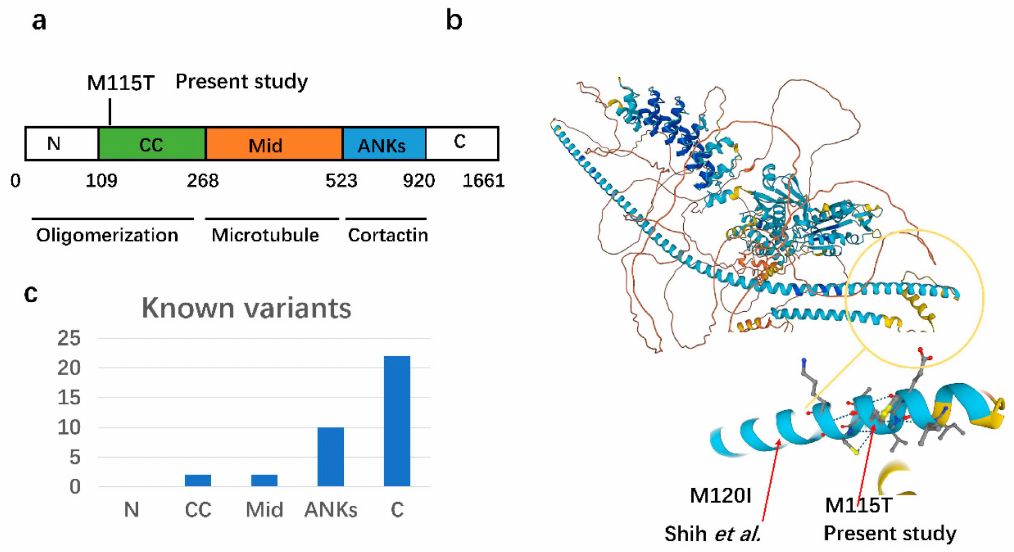
Figure 3. Structure of the M115T mutation in the CTTNBP2 encoded protein and known CTTNBP2 mutation statistics. ( a ) Illustration of the important structural domain of the protein encoded by the CTTNBP2 gene. The M115T mutation is located in the N-terminal coiled-coil (CC) region, which mediates the oligomerization of the CTTNBP2 protein and can affect the CTTNBP2 protein binding to the cortactin protein. Shih et al. found that the M120I mutation in the N-terminal region of CTTNBP2 protein negatively affected the interaction of CTTNBP2 with cortactin; mice exhibited reduced social interaction after introducing the patient’s CTTNBP2 gene heterozygous mutation M120I into mice [26]. The M115T mutation identified in the present study is very close to M120I. ( b ) A 3D structural illustration of the protein encoding CTTNBP2, obtained by AlphaFold [46,47] Protein Structure Database (https://alphafold.com/entry/Q8WZ74, accessed on 1 November 2022). ( c ) Bar plot of ASD risk variants identified in the CTTNBP2 gene according to different regions featuring 39 variants in SFARI gene database (https://gene.sfari.org/database/human-gene/CTTNBP2#variants-tab (accessed on 1 November 2022)); one of the synonymous mutations was